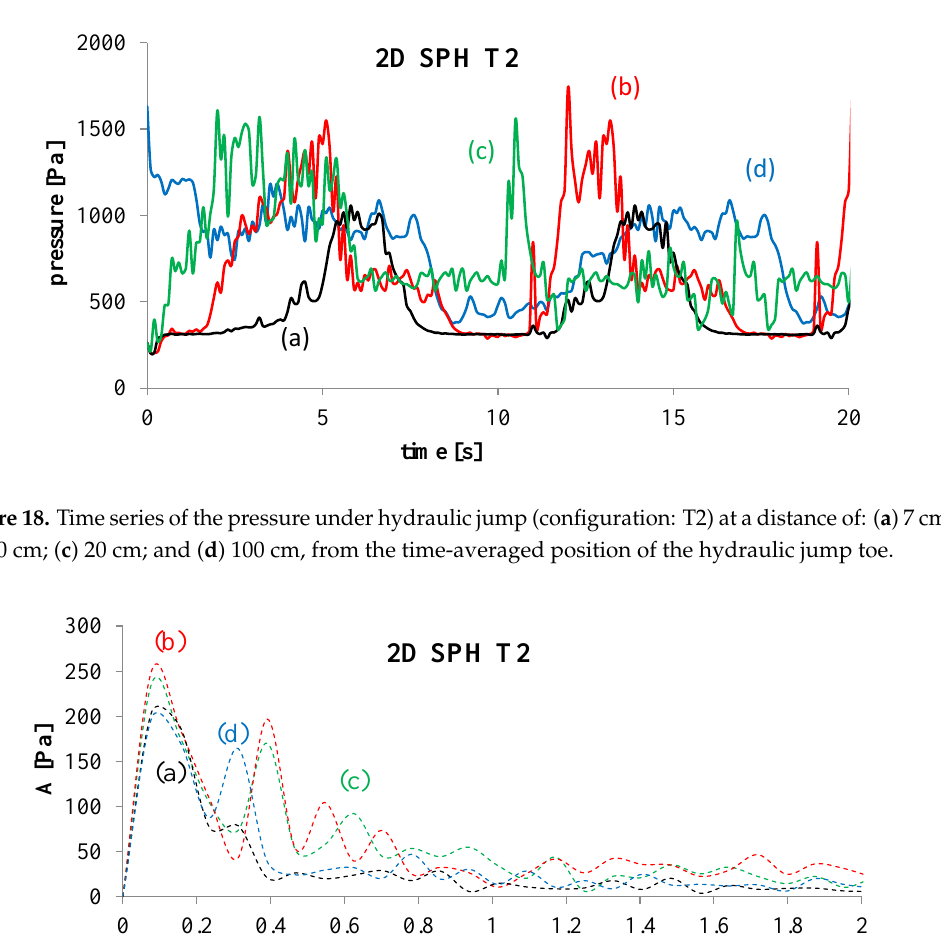
Figure 17. Amplitude spectrum of pressure fluctuations under hydraulic jump (configuration: T1) at a distance of: ( a ) 7 cm; ( b ) 10 cm; ( c ) 20 cm; and ( d ) 100 cm, from the time-averaged position of the hydraulic jump toe.